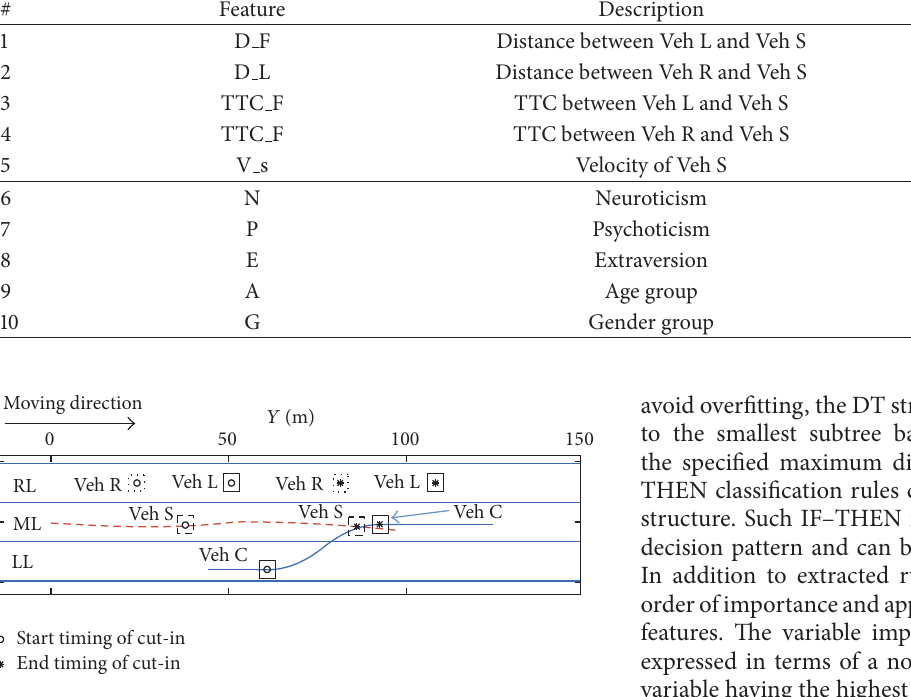
Figure 5: Cut-in trajectory in a BRK